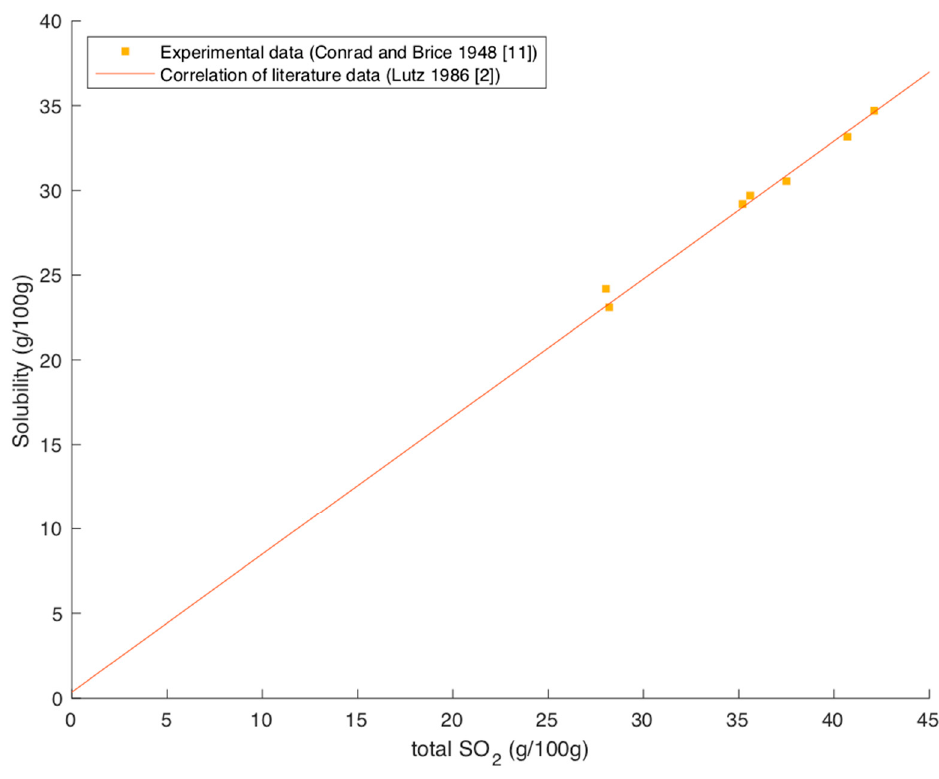
Figure 3. Solubility of MgSO 3 over total SO 2 content in the solution [2,11].